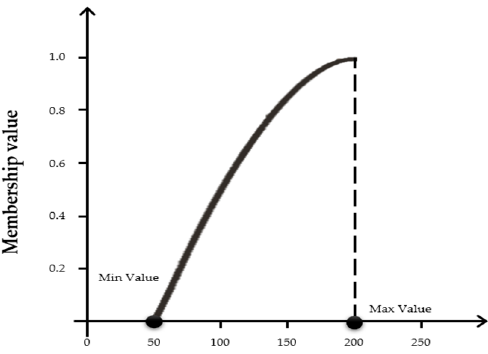
Figure 4. Membership function corresponding to the sine curve [61].